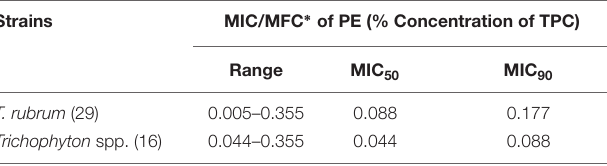
TABLE 1 | Evaluation of Minimum Inhibitory Concentration (MIC) and Minimum Fungicidal Concentration (MFC) of propolis extract (PE) against planktonic cells of Trichophyton spp. isolated from onychomycosis